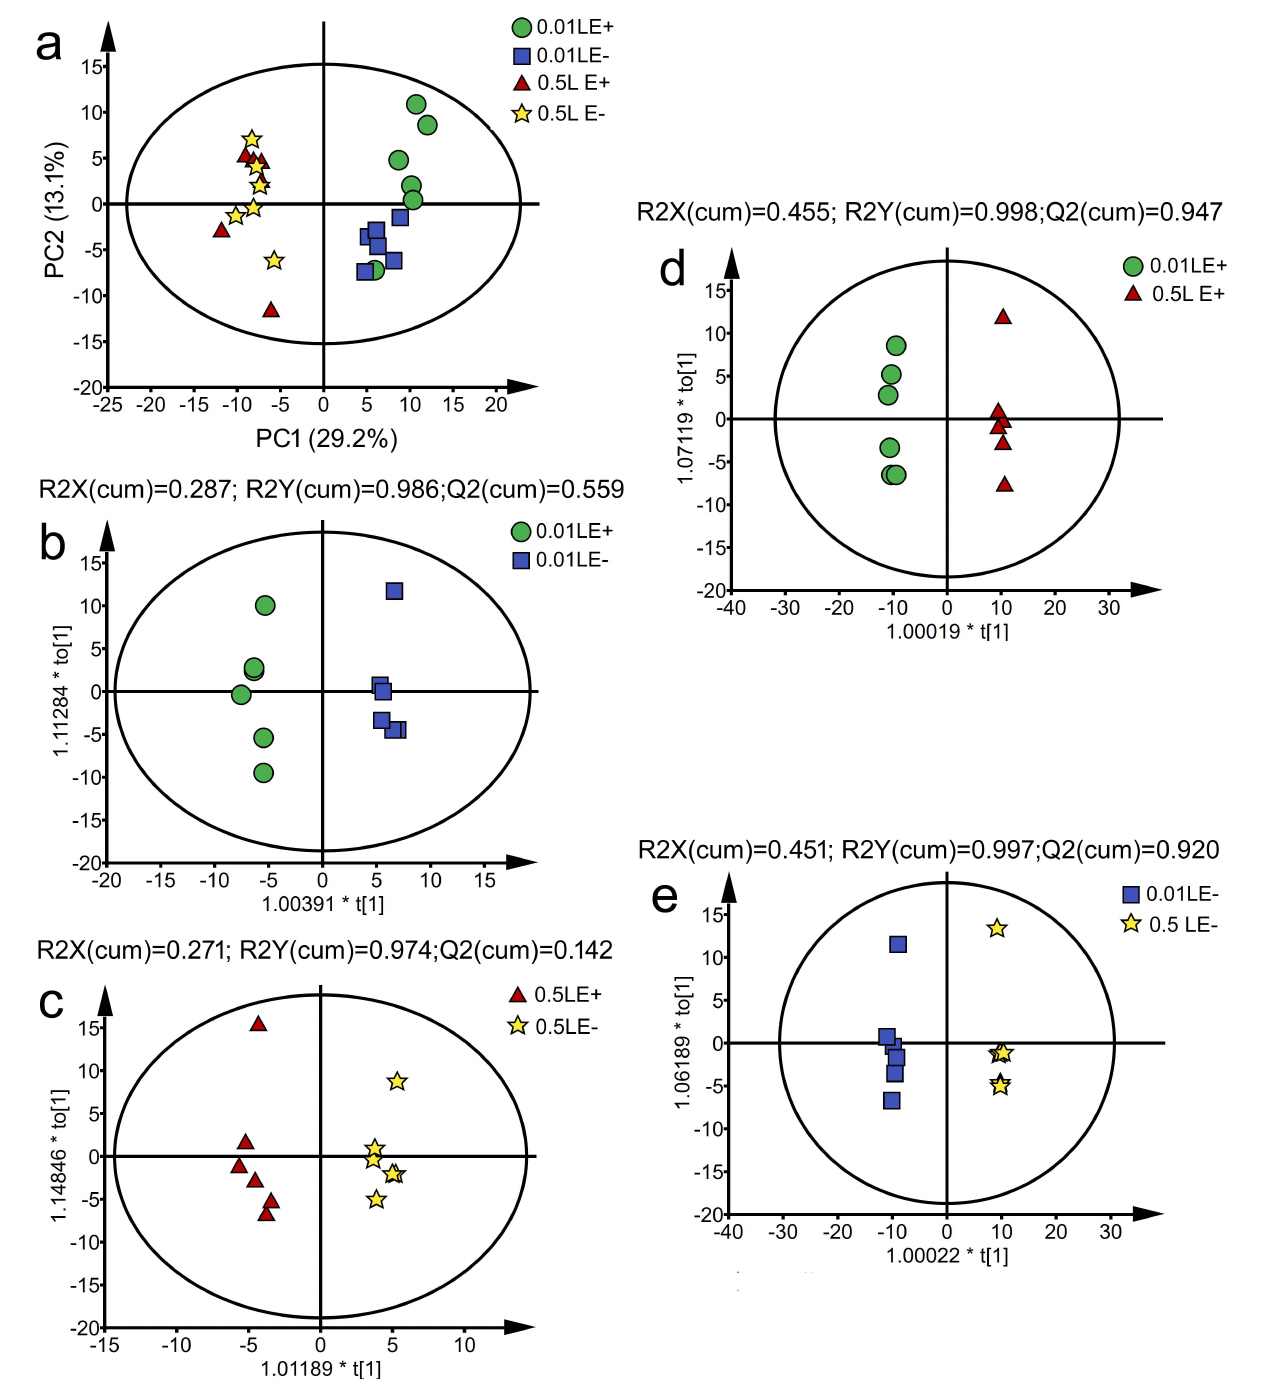
Figure 4. The PCA displayed the metabolic profiles in E+ and E − leaves at 0.01 and 0.5 mM P ( a ). OPLS-DA displayed Epichloë gansuensis effects on the metabolism of Achnatherum inebrians leaves between LE+ and LE − at 0.01 mM P ( b ), between LE+ and LE − at 0.5 mM P ( c ); and dose-dependence of P effects on the metabolism of Achnatherum inebrians leaves between 0.01 and 0.5 mM P in LE+ ( d ), between 0.01 and 0.5 mM P in LE − ( e ). LE+: E+ leaves, LE − : E −